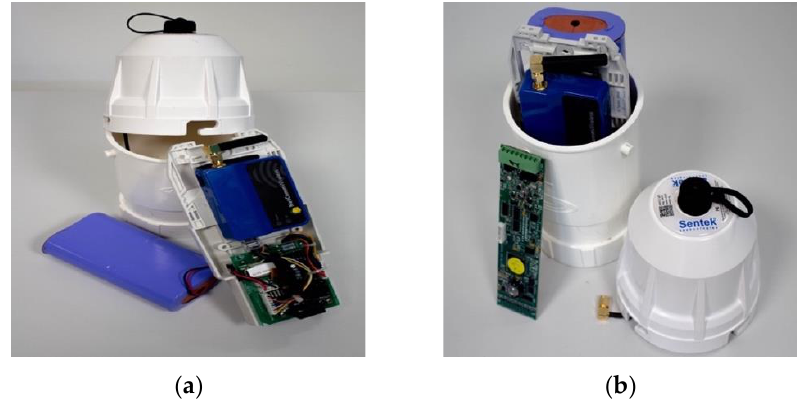
Figure 5. ( a ) The modem and battery; ( b ) The plastic holder and the electronic interface board.